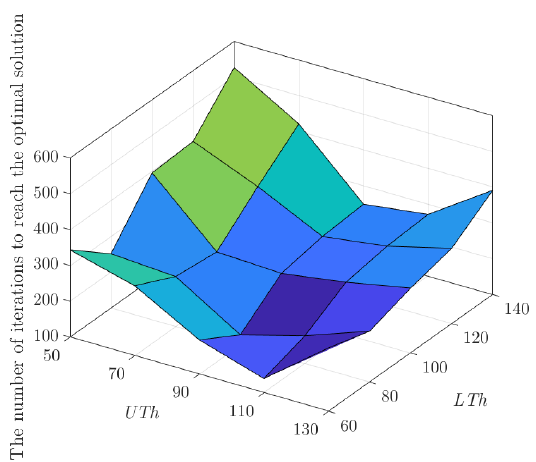
Figure 2. Aquila optimization parameter diagram.